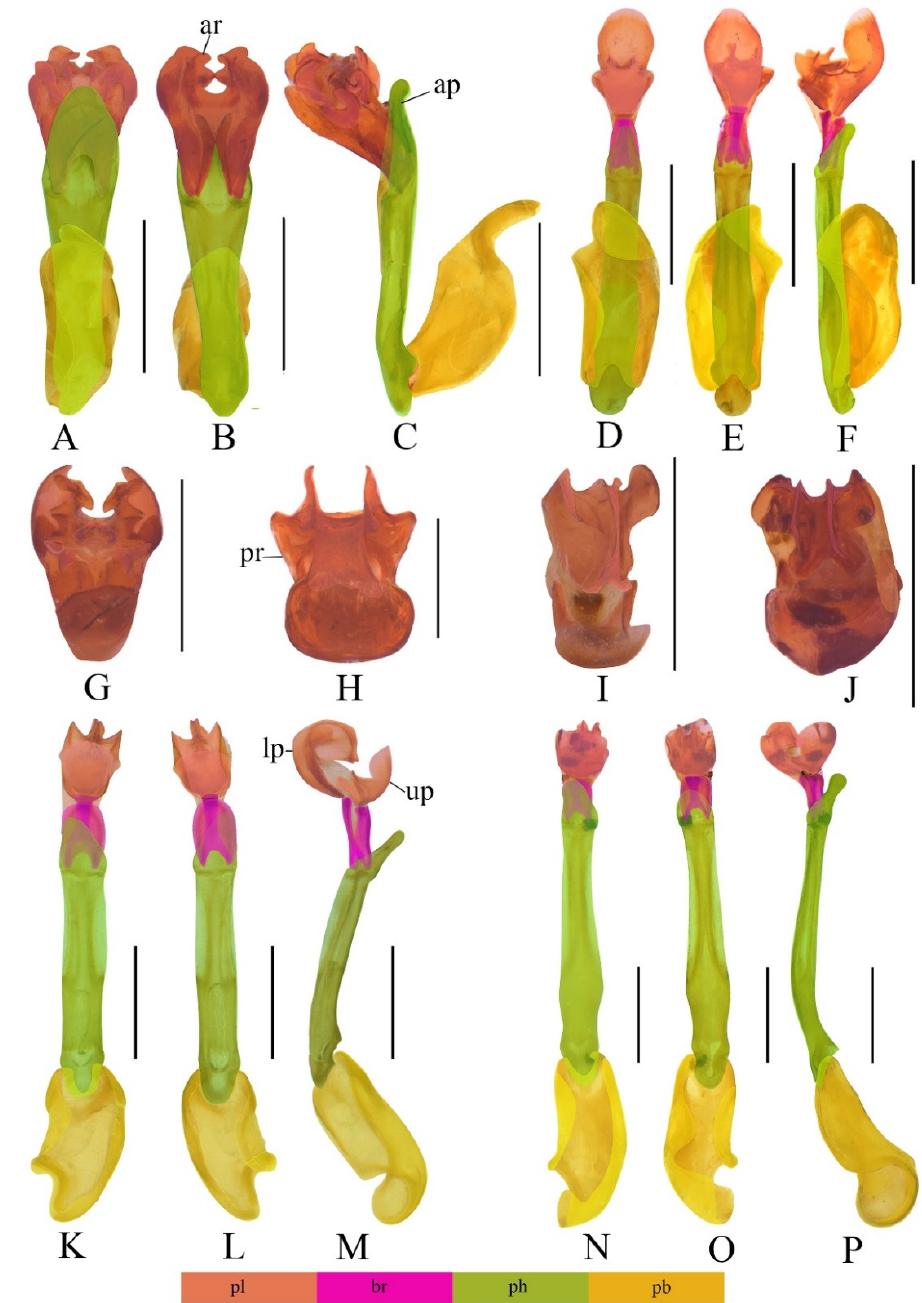
Figure 1. Aedeagi of Mesolycus species: ( A – C , G ). M . rubromarginatus Kazantsev, 2013; ( D – F , H ). M. dentatus sp. n.; ( K – M , I ). M . qinlinganus Kazantsev, 2000; ( N – P , J ). M . shaanxiensis sp. n.: ( A , D , K , N )— ventrally; ( B , E , L , O )—dorsally; ( C , F , M , P )—laterally; ( G – J )—apically. Scales: ( A – G , I – P ), 0.5 mm; ( H ), 0.2 mm. pl—plate; br—basal rods; ph—phallus; pb—phallobase; ar—apical ring; ap—apical hood; lp—lower plate; up—upper plate; pr—ventro-apical process.